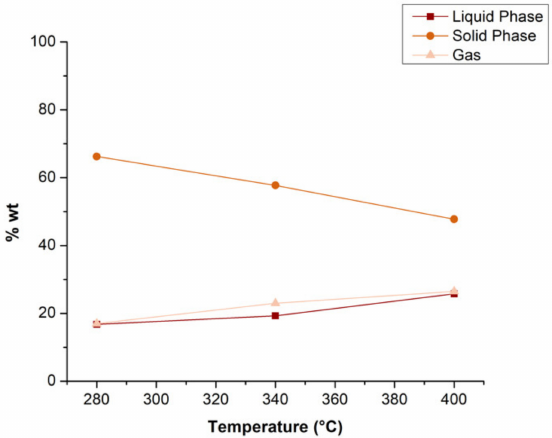
Figure 4. Products’ yields at each pyrolysis